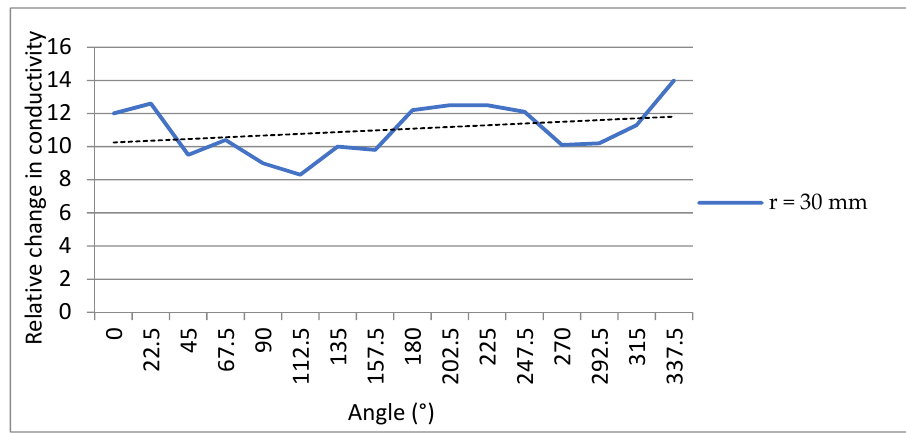
Figure 16. The sensitivity in circular direction.